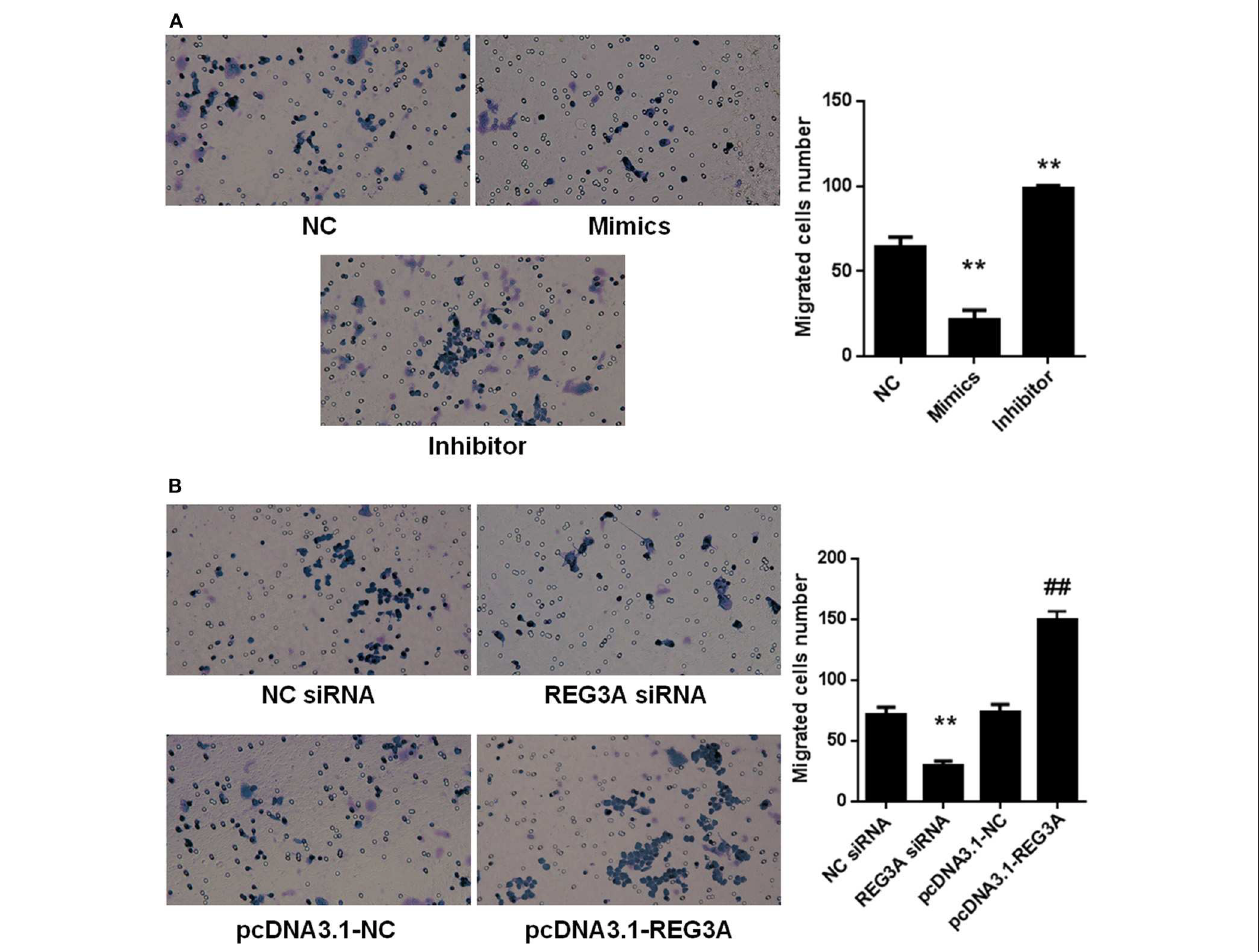
FIGURE 3 | The effects of miR-146a and regenerating islet-derived protein 3-alpha (REG3A) on macrophage migration. (A) Monocyte-derived macrophages from the PBMCs of the healthy donors ( n = 3) were transfected with the negative control (NC) microRNA (miRNA) and miR-146a mimics, miR-146a inhibitors for 24h. (B) Monocyte-derived macrophages from the peripheral blood mononuclear cells (PBMCs) of the healthy donors ( n = 3) were transfected with the NC siRNA, REG3A siRNA, pcDNA3.1-NC, and pcDNA3.1-REG3A plasmids for 24h. All treated cells (2 × 10 5 ) were suspended and added to the upper chamber of transwell. The medium containing 10% human serum was used as a chemoattractant in the lower chamber. After incubation for 24h, the invaded cells into the lower chamber were stained with crystal violet. The migrated cells were counted, and photomicrographs were taken under an Olympus inverted microscope (IX71, Olympus, Japan). Data are shown as means ± SEM of three independent experiments. * p < 0.05, ** p < 0.01 in comparison with the control group. ## p < 0.05 in comparison with pcDNA3.1-NC